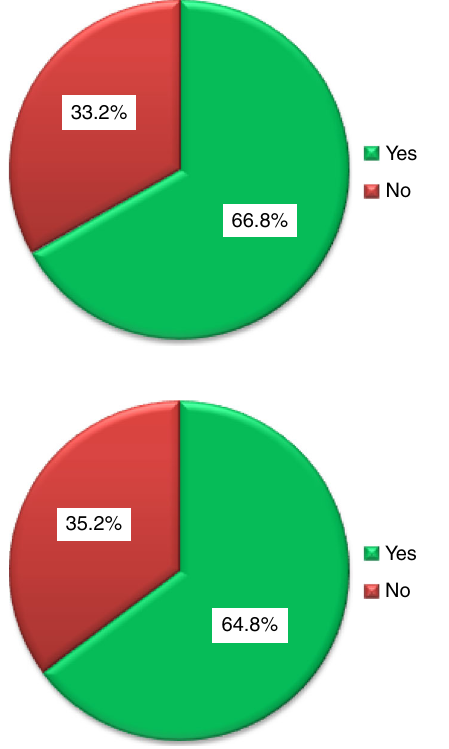
Figure 13. Equip